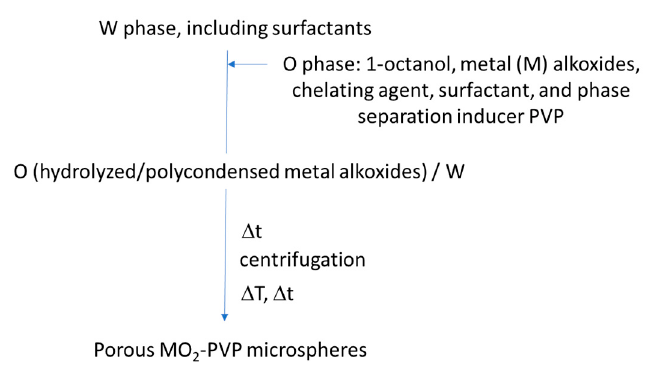
Figure 21. Representative synthesis flowchart, employing O/W emulsification as soft template, and sol-gel/phase separation, for the achievement of metal oxide microspheres with incontinuous inner macroporosity [125] (Marques et al., original schemes).